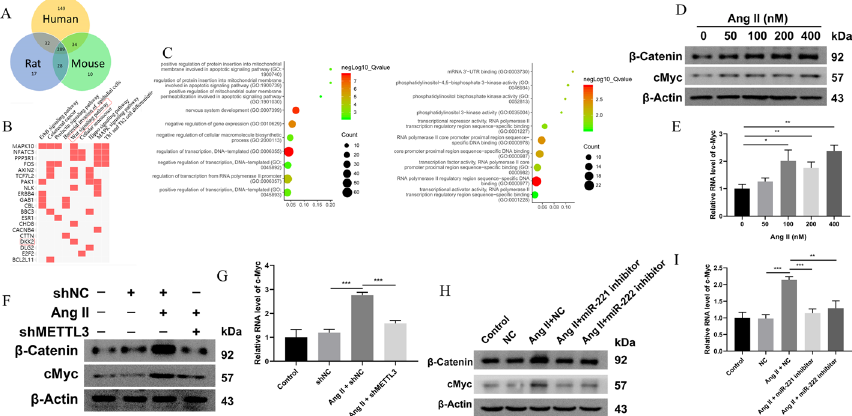
Fig. 5 Wnt/β ‐ catenin was downstream regulated by METTL3 and miR-221/222. A Venn diagram indicating the targets of miR-221/222 in human, rat, and mouse. B KEGG analysis of the 289 intersection target genes of three species. C GO analysis of the 289 intersection target genes of three species. D Western blot detected the expression of β ‐ catenin and c-Myc in NRCMs stimulated with Ang-II. n expression of c-Myc in NRCMs stimulated with Ang-II. n β ‐ catenin and c-Myc in Ang-II-induced NRCMs with METTL3 knockdown. n expression of c-Myc in Ang-II-induced NRCMs with METTL3 knockdown. n expression of β ‐ catenin and c-Myc in Ang-II-induced NRCMs with miR-221/222 inhibition. n detected the expression of c-Myc in Ang-II-induced NRCMs with miR-221/222 inhibition. n ** P < 0.01, *** P <